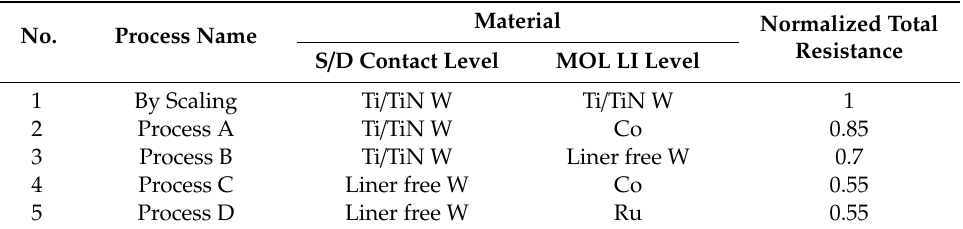
Table 3. Summary of all MOL Metallization Options